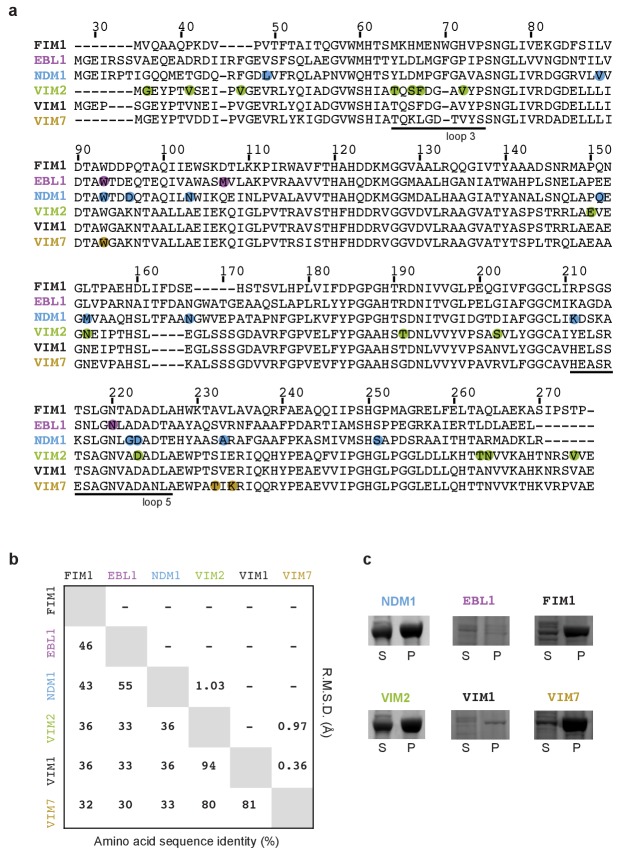
Sequence comparison between metallo-β-lactamases.(A) Sequence alignment of selected metallo-β-lactamases. Residue number is based on the NDM1 sequence (PDB-ID 3spu). Positions that were mutated and selected during the directed evolution of PMH activities are highlighted in color. Actual mutations are listed in Supplementary file 1B. (B) Sequence identity and structure similarity among selected B1 β-lactamases. A multiple sequence alignment of the nine B1 β-lactamases using ClustalW2 (standard parameters), which was then used to calculate the pairwise sequence identities using the web-based program SIAS (hcp://imed.med.ucm.es/Tools/sias.html) with gaps taken into account. To determine pairwise structural similarity, we computed the root mean standard deviation (RMSD) between all structure pairs using the align command PyMOL. (C) SDS-PAGE images of protein expression in the supernatant (S) and pellet (P) fractions of the cell lysate. Images for NDM1 and Vim2 are the same as the ones used in Figure 3—figure supplement 1.